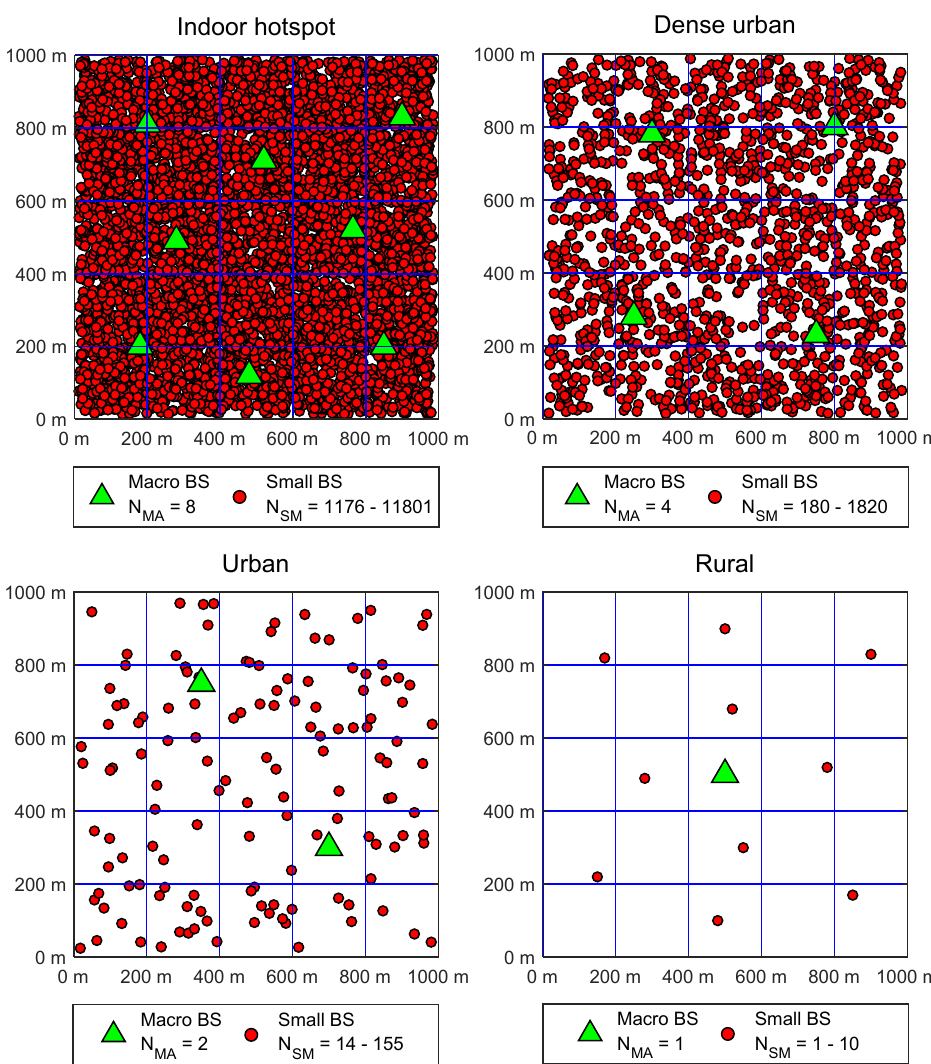
Figure 1. Visualization of analyzed 5G HetNet deployments for different device density classes with the maximal number of installed small and macro BSs per square kilometer area.